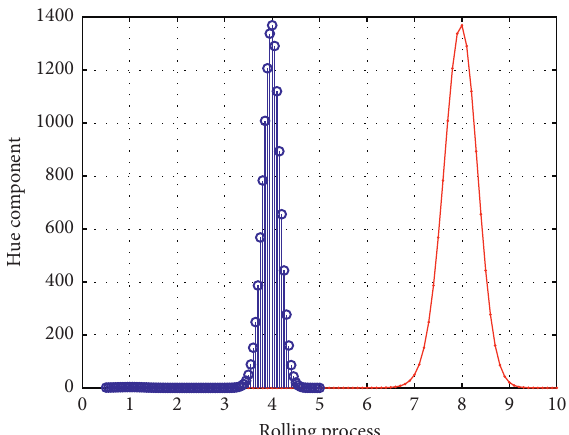
Figure 7: Color histogram of the hue component of the target (a).